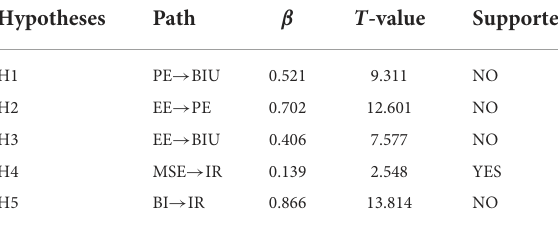
TABLE 6 Research hypotheses tested-direct